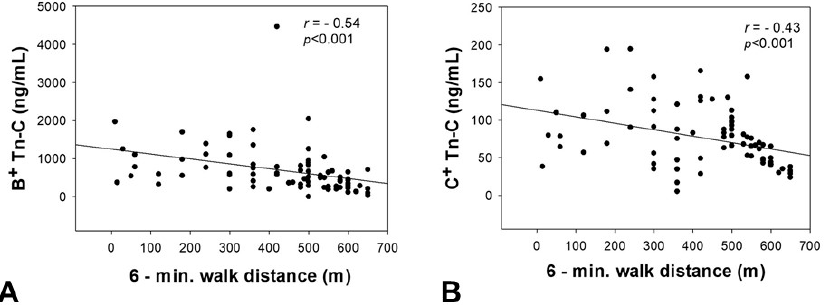
Figure 4. Correlation analyses between the serum concentration of B + ( A ) and C + ( B ) Tn-C and the 6-min walk distance. Tn-C = tenascin C, p -value = level of significance, r -value = correlation coefficient.